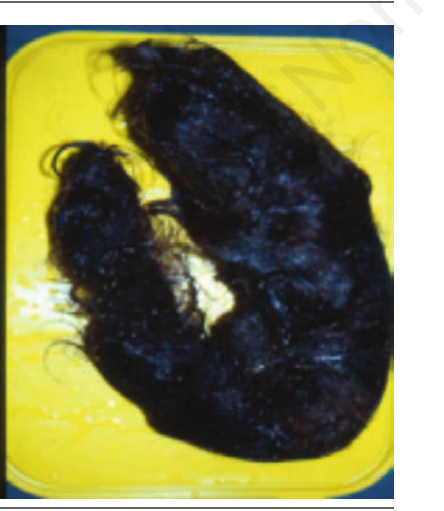
Figure 2. Rare scalp with damaged hair.